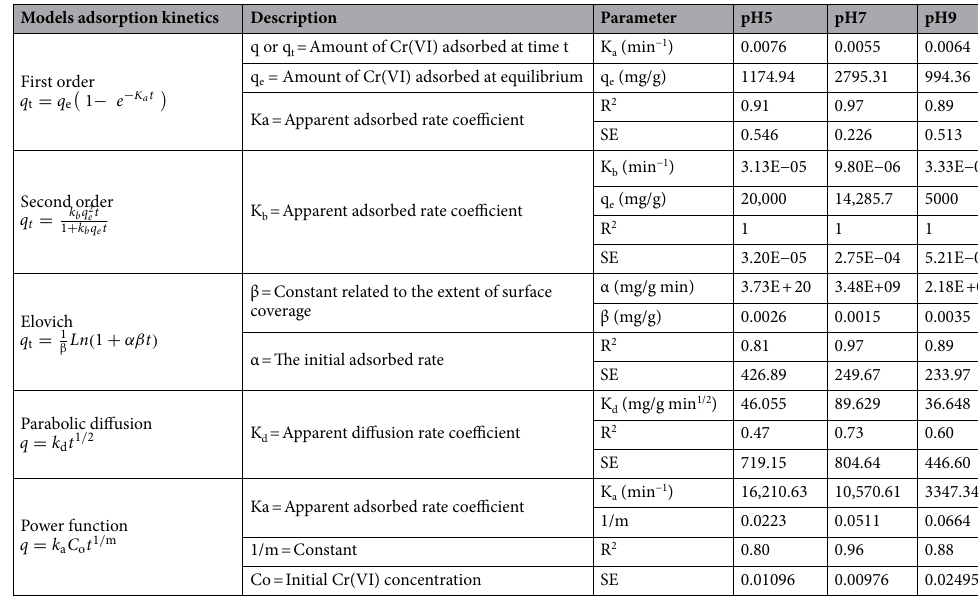
Table 2. The parameters of kinetic models for Cr(VI) adsorption by the three various pH